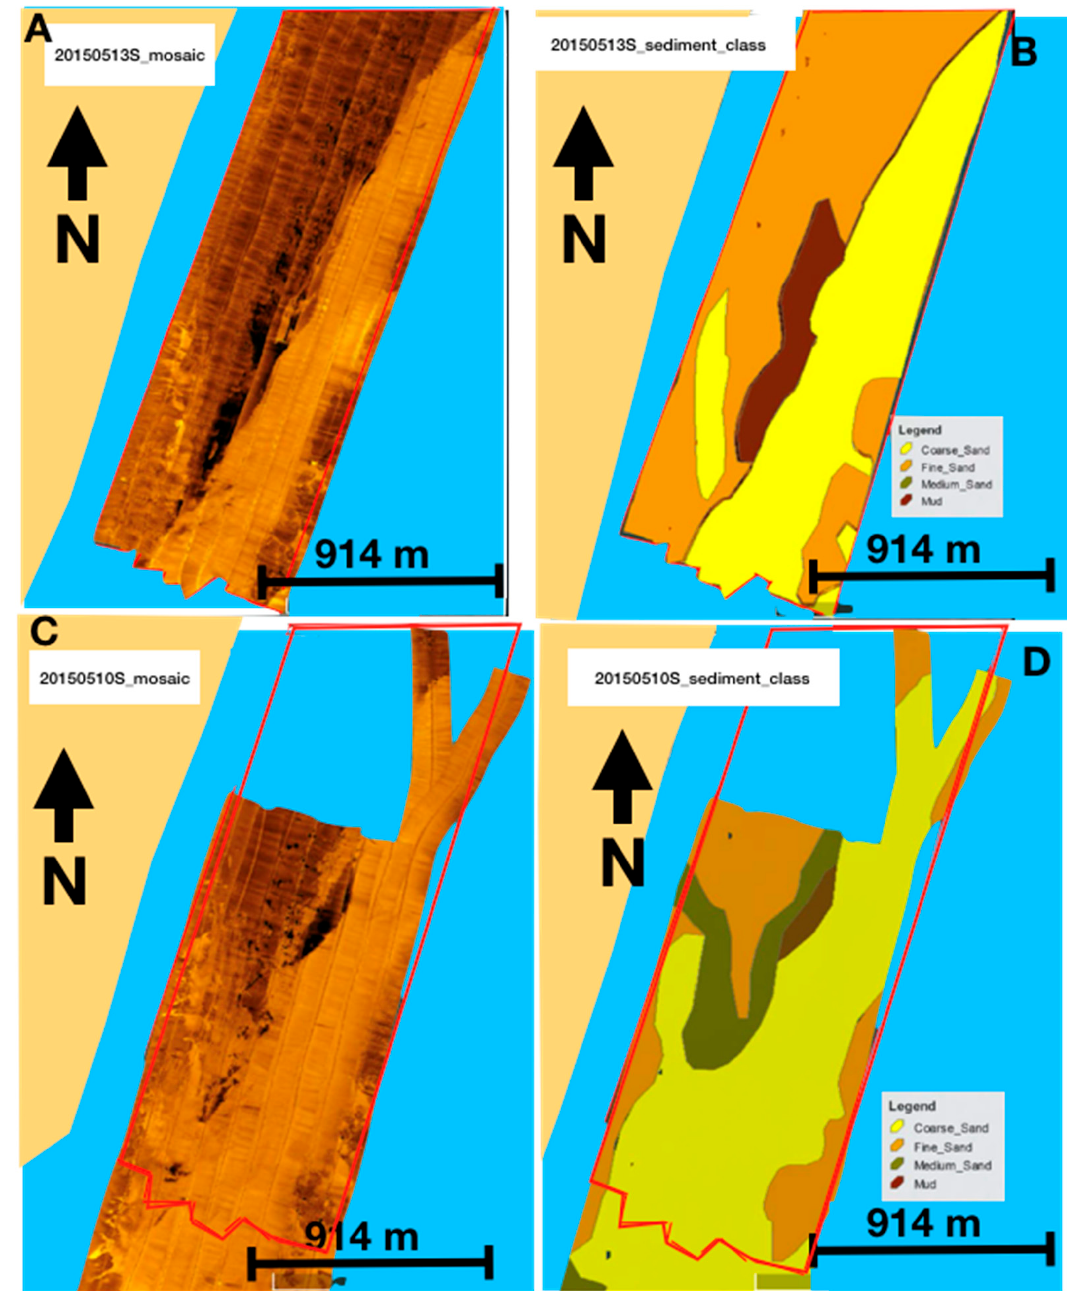
Figure 16. Side-scan sonar mosaic interpretation, Assateague Island National Seashore, Maryland. ( A ) Side-scan sonar mosaics collected during 13 May 2015; ( B ) Interpretation of side-scan sonar data collected in 13 May 2015; ( C ) side-scan sonar mosaics collected in October 2015; ( D ) Interpretation of side-scan sonar mosaics collected in October 2015. Note that red polygons represent the same areas mapped during both 13 May 2015 and October 2015.